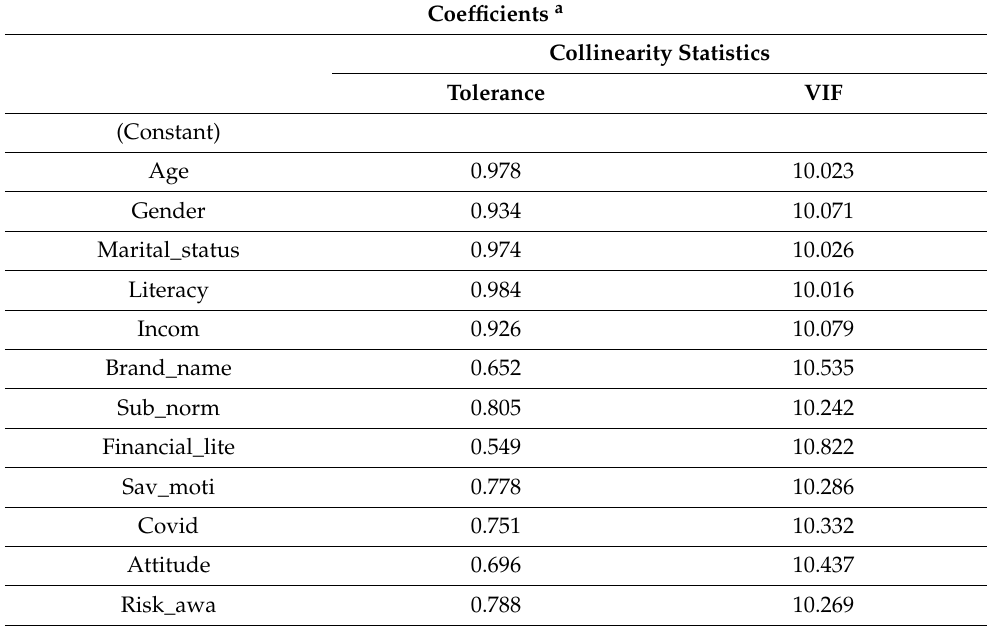
Table 6. Multicollinearity